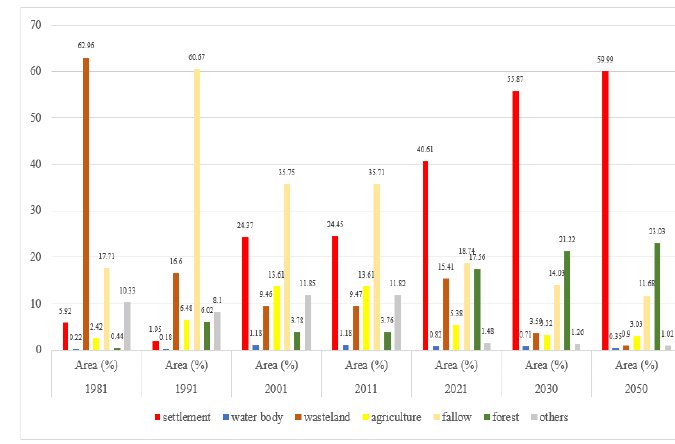
shows a declining trend in the agricultural areas.